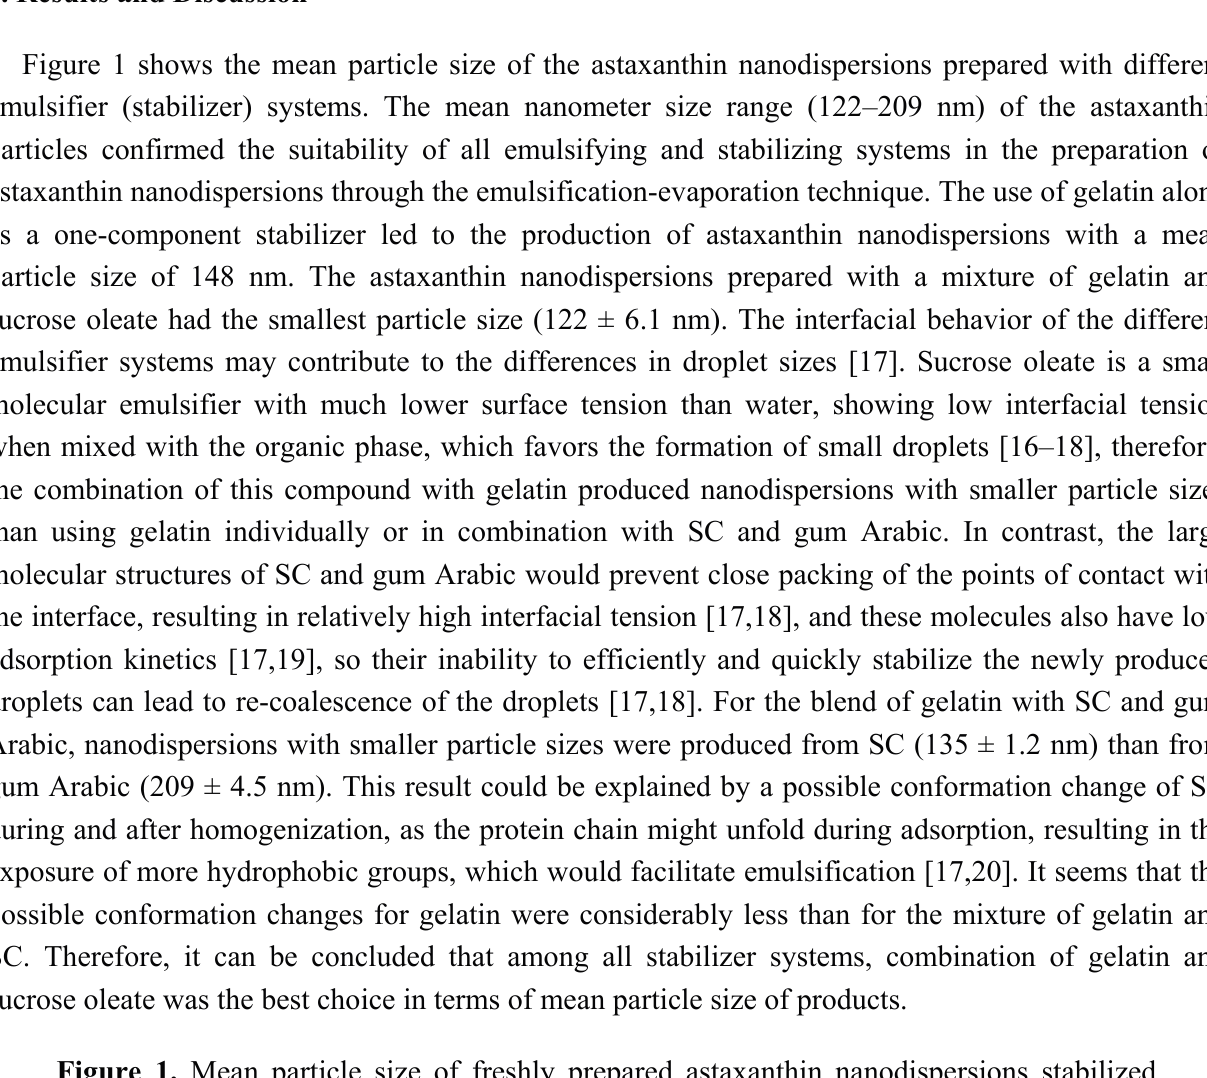
Figure 1. Mean particle size of freshly prepared astaxanthin nanodispersions stabilized with different gelatin based emulsifying